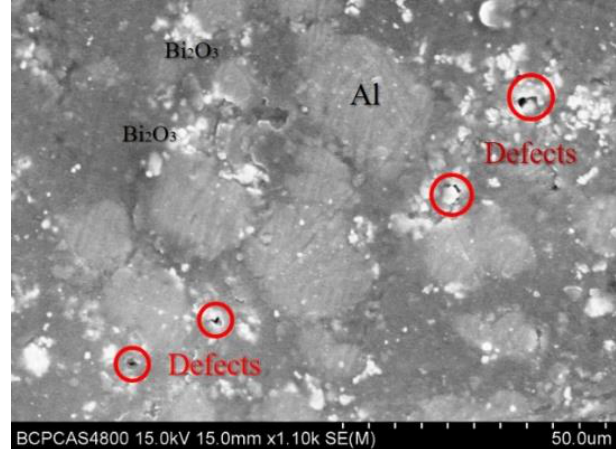
Figure 8. Typical SEM photographs of PAB.